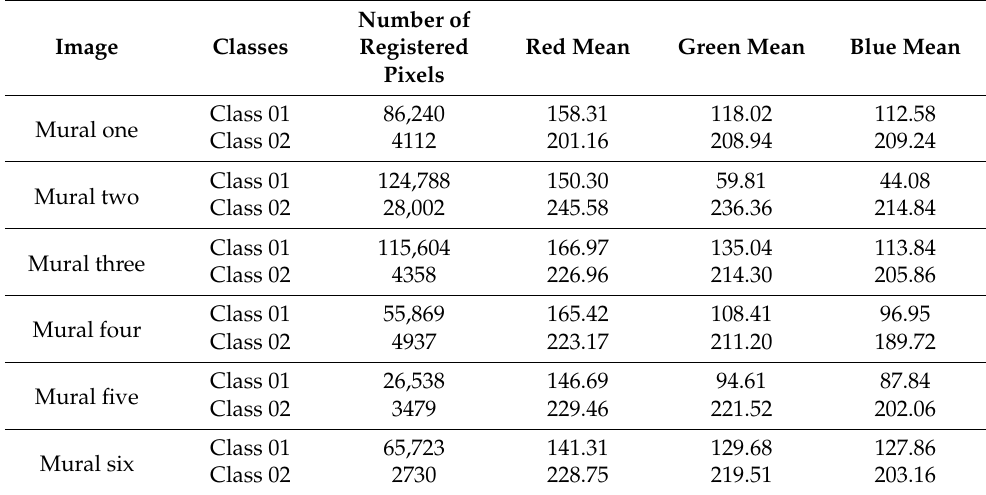
Table 1. Number of registered pixels for each class and the calculated of the mean values of each color channel (red, green, and blue).